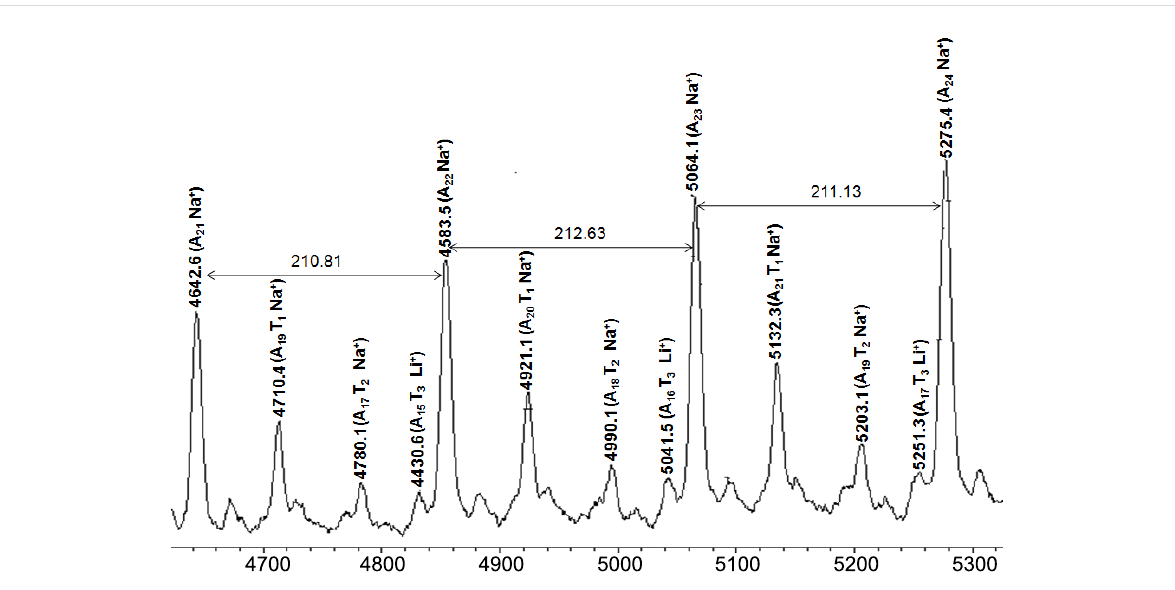
homopolymer A n (visible as A n Na + -series) is present in